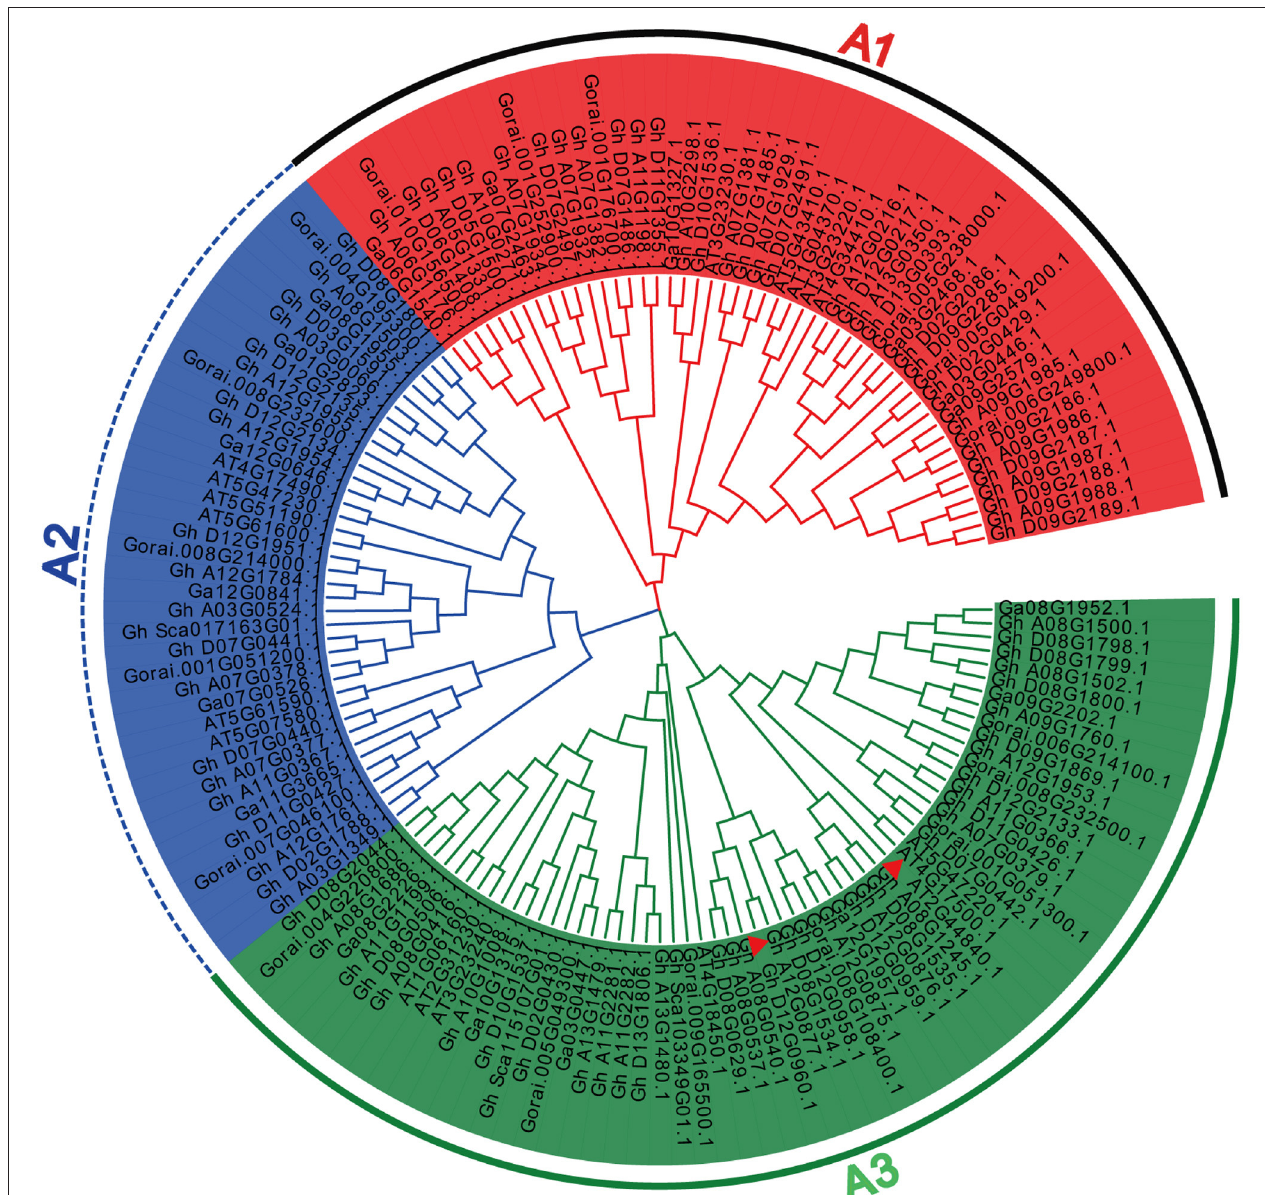
FIGURE 1 | Phylogenetic analysis of the (ERF) subfamily B3 group gene family. The 148 genes were divided into three groups (A1–A3). These genes were found in A. thaliana , G. arboreum , G. hirsutum , and G. raimondii . The NJ method was used to build the phylogenetic tree, and topological robustness was evaluated by bootstrapping with 1,000 replications. The cotton and Arabidopsis ERF accessions are indicated. The gene marked with a red triangle corresponds to ERF13 in Arabidopsis and